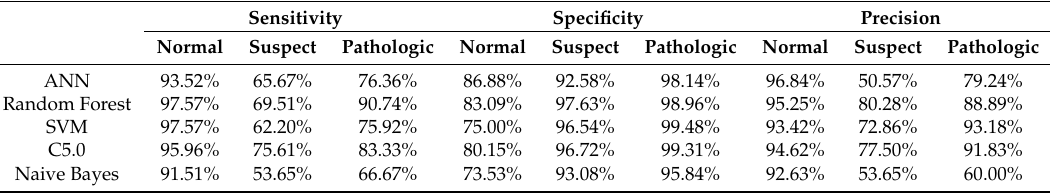
Table 7. Evaluation Criteria for Diabetics patient data after Genetic